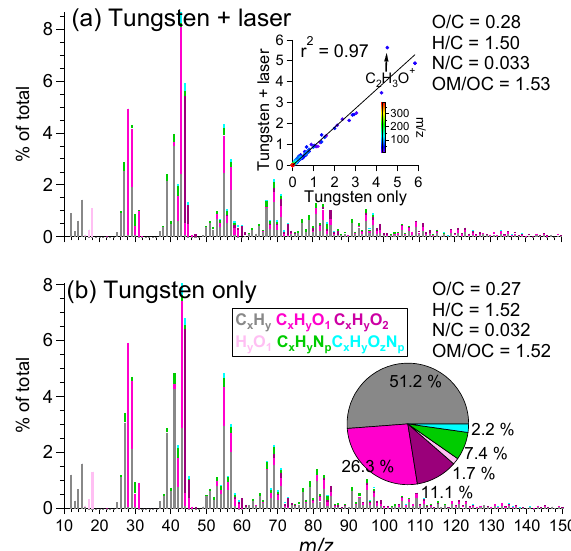
Figure 7. Campaign-averaged high-resolution mass spectra of OA colored by six ion categories, in the case of (a) dual vaporizers (Tungsten + laser) (the inset scatter plot compares the spectral simi- larity between panels a and b ), and (b) Tungsten vaporizer only (the inset pie shows the relative contributions of six ion categories to the total